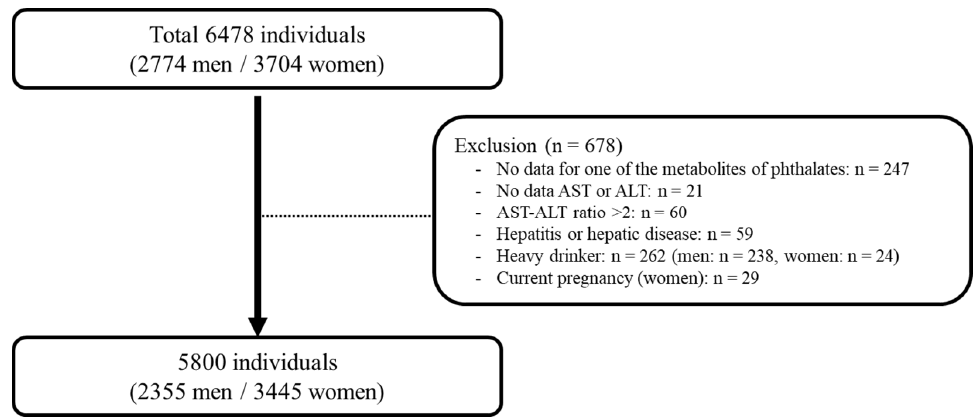
Figure 1. Study population in the present study obtained from the Korean National Environmental Health Survey II (2012–2014). AST: aspartate aminotransferase; ALT: alanine